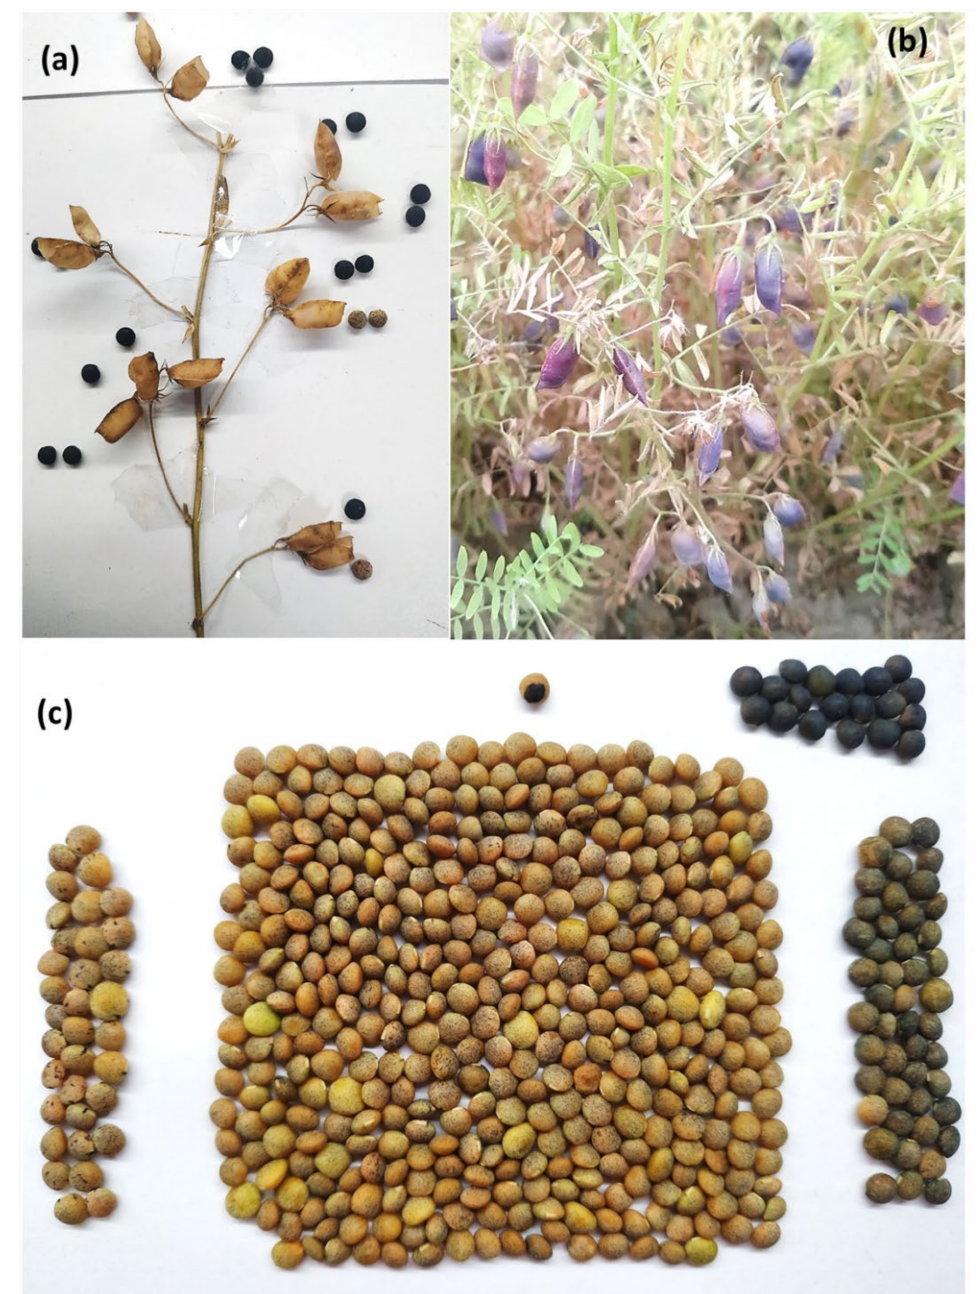
Figure 9. ( a ) A lentil branch showing both black and brown seed-coat color in lentil genotype L4717- NM; ( b ) a lentil plant having black seed-coat lentils with deep purple pigmentation in the pods before full maturity; ( c ) different seed-coat colored lentil seeds produced from a single